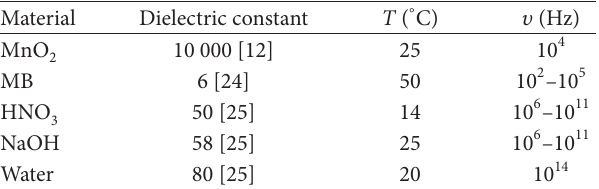
T 2: Dielectric constant of materials used in this study.